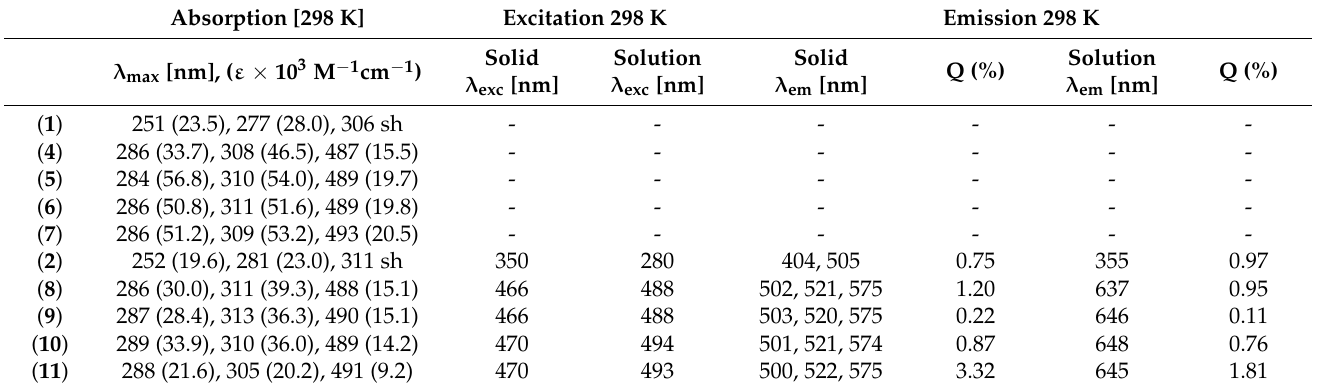
Figure 3. Normalized UV-Vis spectra of the complexes ( a ), ( 4 )–( 7 ) and ( b ), ( 8 )–( 11 ) in acetonitrile. Table 1. Photophysical data for ( 1 ), ( 2 ) and ( 4 )–( 11 ) in solid state and in acetonitrile